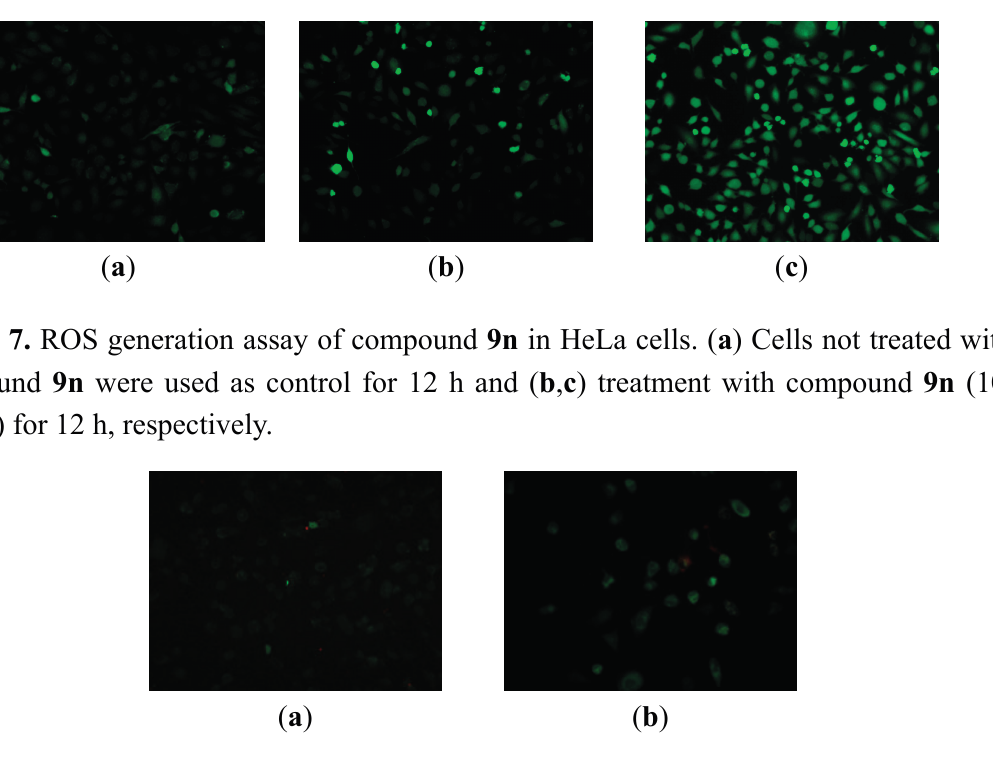
Figure 8. Investigation of the effect of compound 9n on calcium release. ( a ) Cells not treated with the 9n were used as control for 24 h; ( b ) HeLa cells treated with compound 9n for 24 h at 10 μ M,